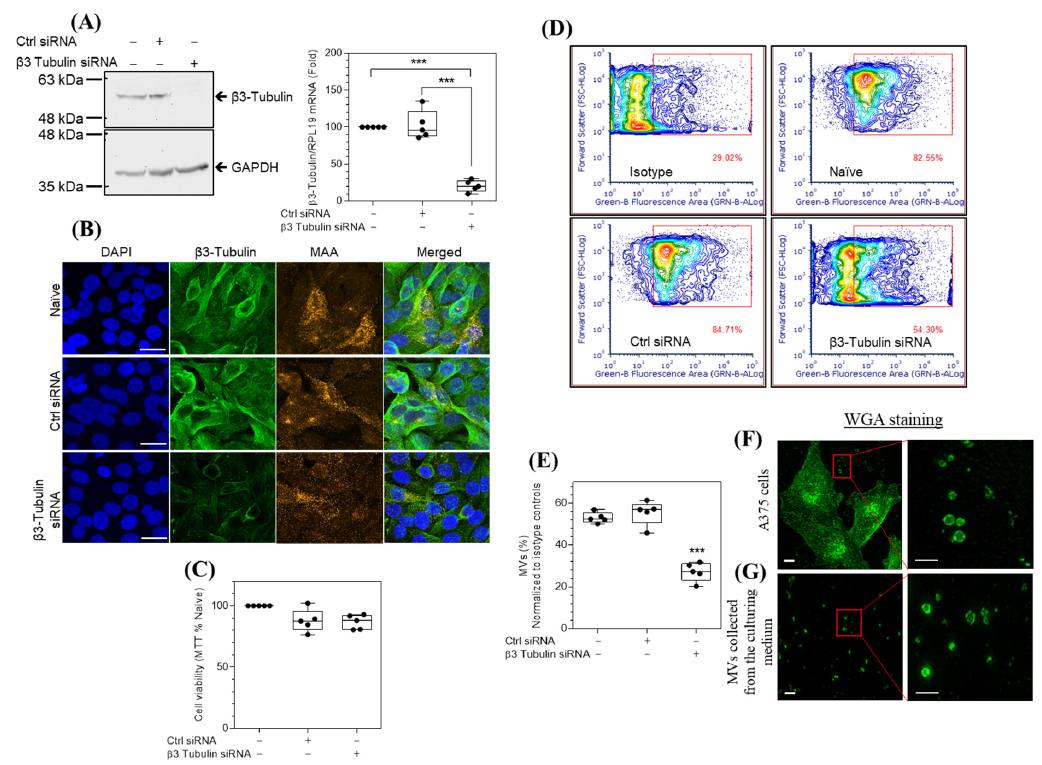
Figure 1. β 3-tubulin knockdown reduces the numbers of microvesicles (MVs) spontaneously released by A375 melanoma cells under the standard culture conditions. ( A ) Western blots of β 3-tubulin and GAPDH loading control (panel A, left), and RT-PCR quantification of β 3-tubulin mRNA expression normalized to the C T values of RPL19 (panel A, right). ( B ) Naïve, control (ctrl) − , and β 3-tubulin siRNA-treated cells were immunostained with antibodies specific for β 3-tubulin (green) and MAA (orange), DAPI (blue) was used as nuclear DNA counterstain, original magnification × 630 (bar, 20 µ m). ( C ) MTT assay shows the e ff ect of siRNA treatment on the cellular viability of A375 cells. Flow cytometric contour plots ( D ) and quantification ( E ) of MVs collected from the culture media of naïve, ctrl-, and β 3-tubulin-siRNA treated cells and immunostained with an MAA antibody or isotype control, plots illustrate the percentage of positively stained MVs (D, red square gated events). Super-resolution microscopy with maximum intensity projection of a confocal stack micrographs of A375 cells ( F ), or MVs collected from culture media ( G ), stained with Alexa fluor 488-conjugated-WGA, red rectangles, in F and G, show randomly selected areas for higher magnification (right enlarged micrographs), illustrating ring-like microvesicles of varying sizes (200–1000 nm) with optically clear lumen. Original magnification × 1000, scale bar 5 µ m (left graphs) or 1 µ m (magnified right graphs). Statistical significance was determined between di ff erent groups using an ANOVA with Tukey’s correction for multiple comparisons. n = 5, *** p < 0.001 versus naïve